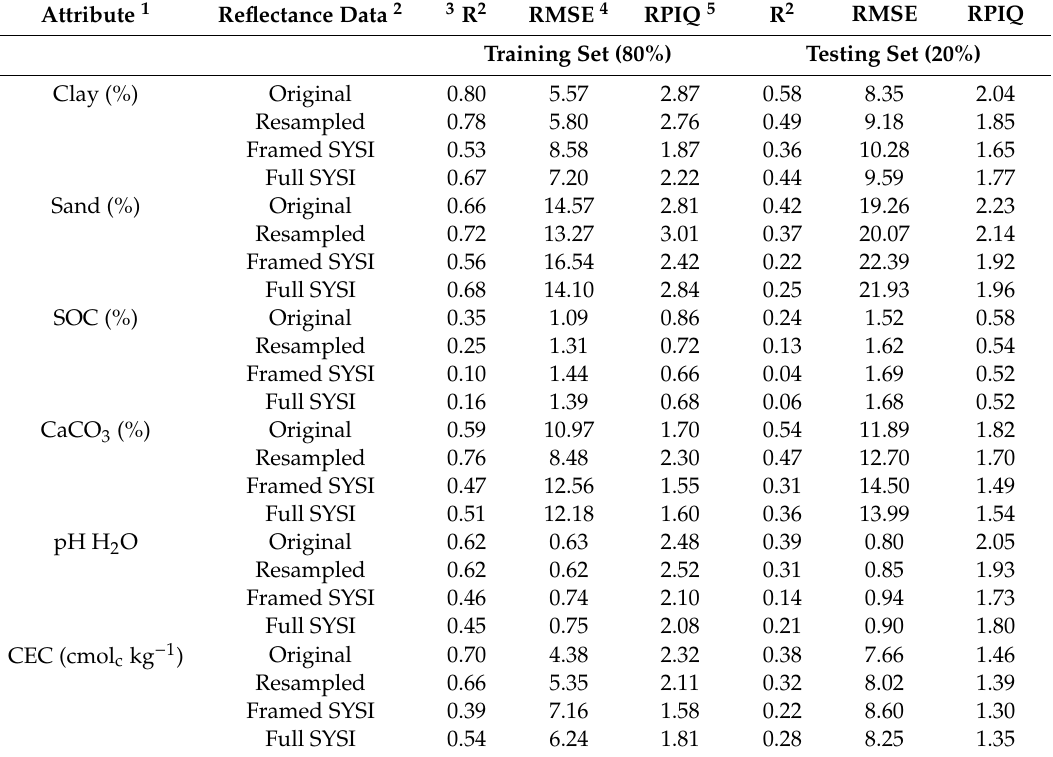
Table 3. Performance of prediction models of soil properties (n = 7142) using reflectance